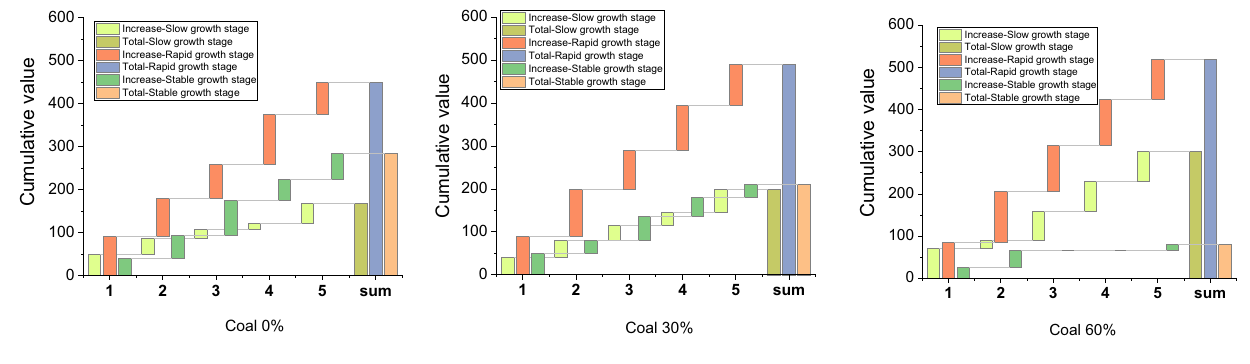
Fig. 7 Strain rate variation of three coal samples with different moisture